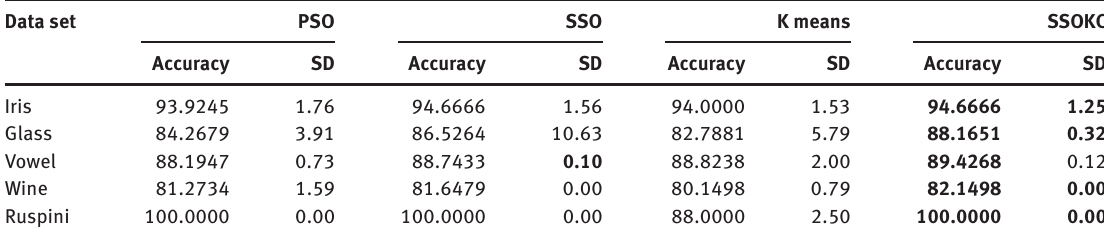
Table 8: Comparison of Accuracy of Clustering Methods. Data set PSO